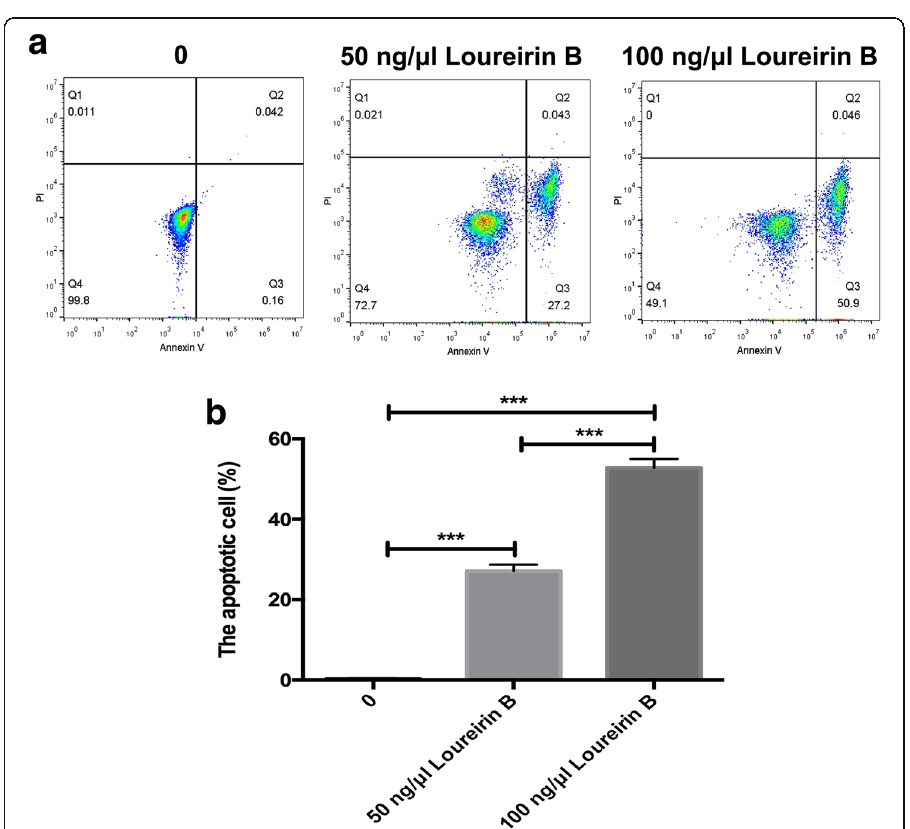
Fig. 2 Loureirin B promotes the apoptosis of HSCs. a Activated hepatic stellate cells (aHSCs) were treated with 50 and 100 ng/ μ l loureirin B for 48 h, and then assessed using flow cytometry. b Statistical analysis of flow cytometry results. Data are the means ± SEM from four independent experiments. * p <0.05; ** p <0.01; *** p